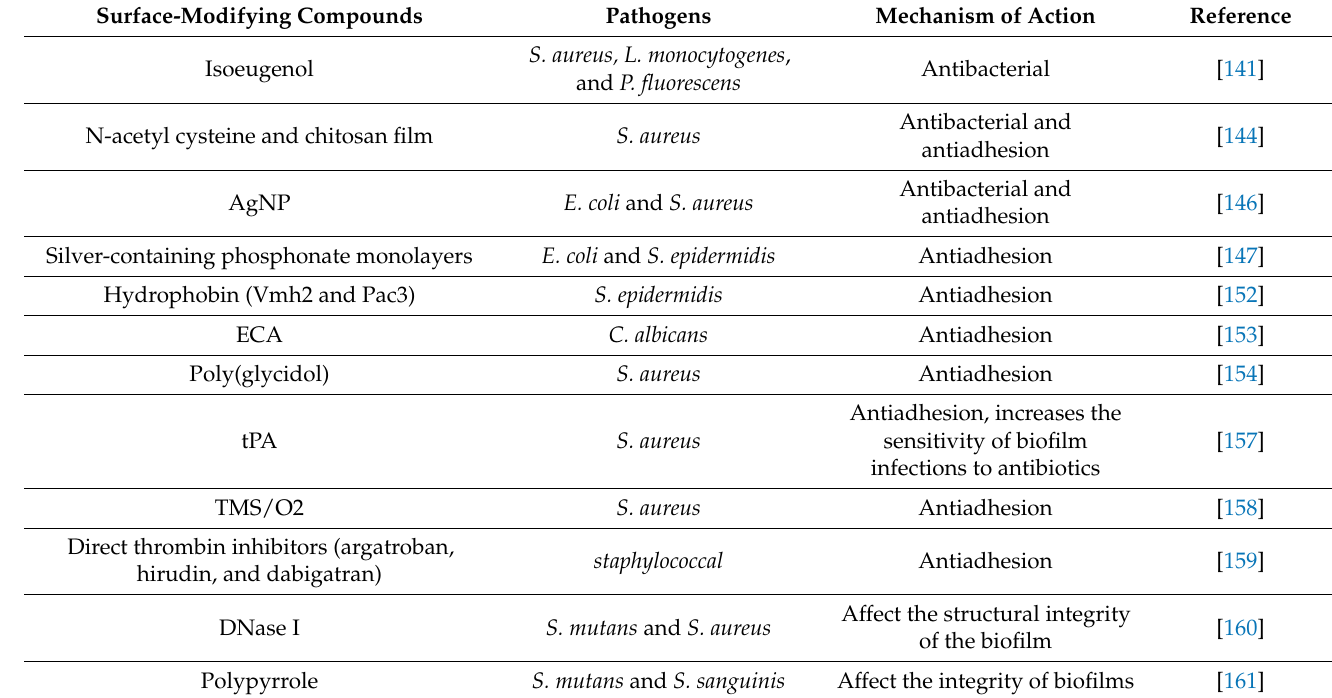
Table 2. Summary of novel surface-modifying compounds used against biofilms and mechanisms of action. Surface-Modifying Compounds